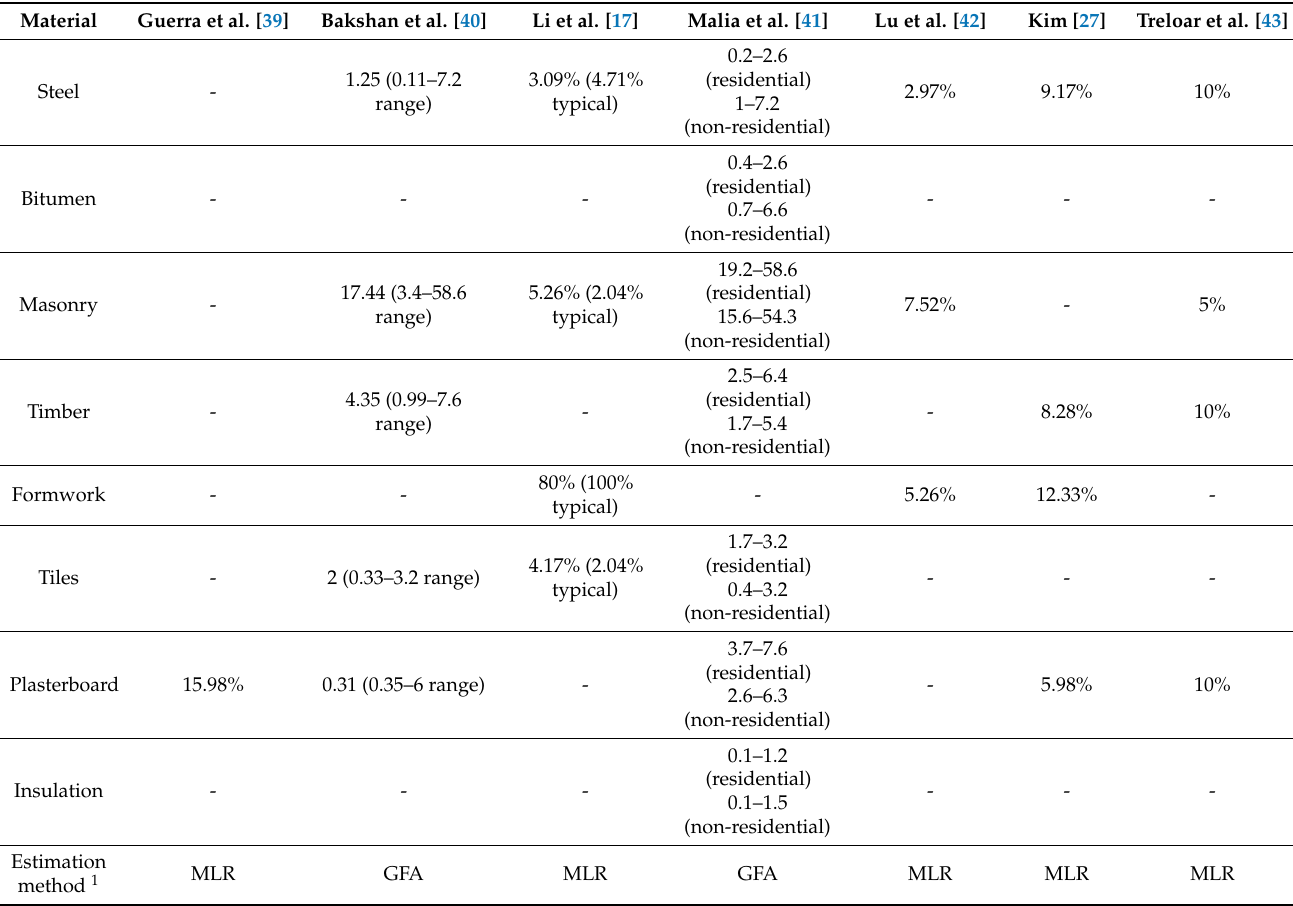
Table 2. Conventional construction waste rates from